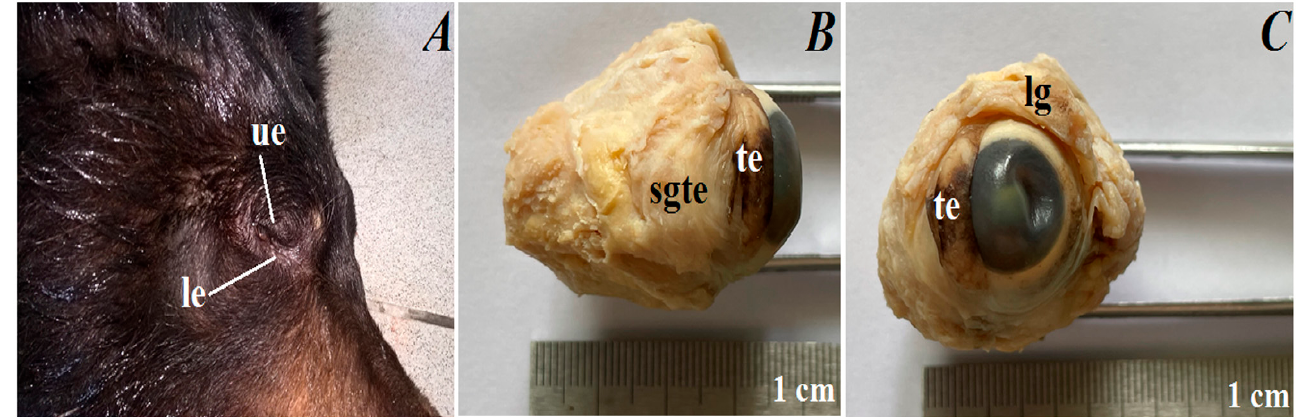
Figure 2. Gross macroscopic image of the Ursus thibetanus eyelids ( A , B ) and orbital glands ( B , C ). le—lower eyelid, lg—lacrimal gland, sgte—superficial gland of third eyelid, te—third eyelid, ue—upper eyelid.